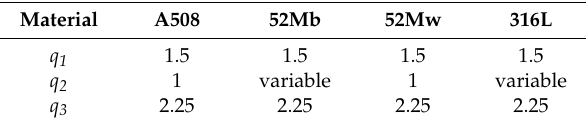
Table 1. The GTN parameters of different materials. Reprinted by permission from Springer, Copyright 2017